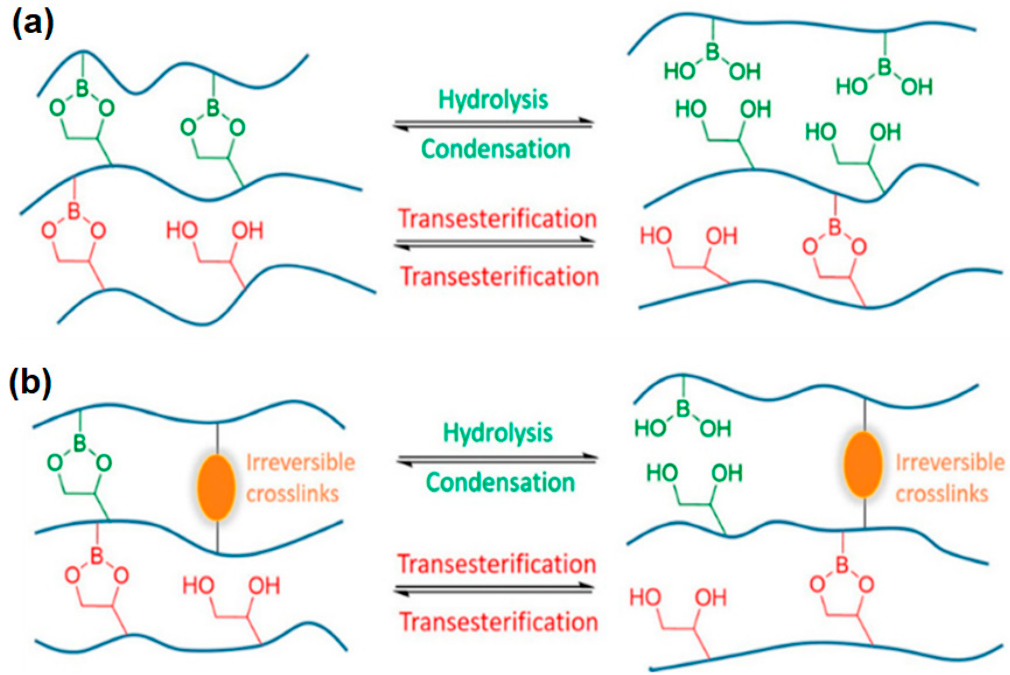
Figure 1. Representation of interlocked molecules in covalent bonding [14]. ( a ) Boronic esters undergo two distinct exchange mechanisms under these conditions. ( b ) When the DDN is reinforced with additional static crosslinks, its dimensional stability is enhanced and properties like creep resistance are improved.